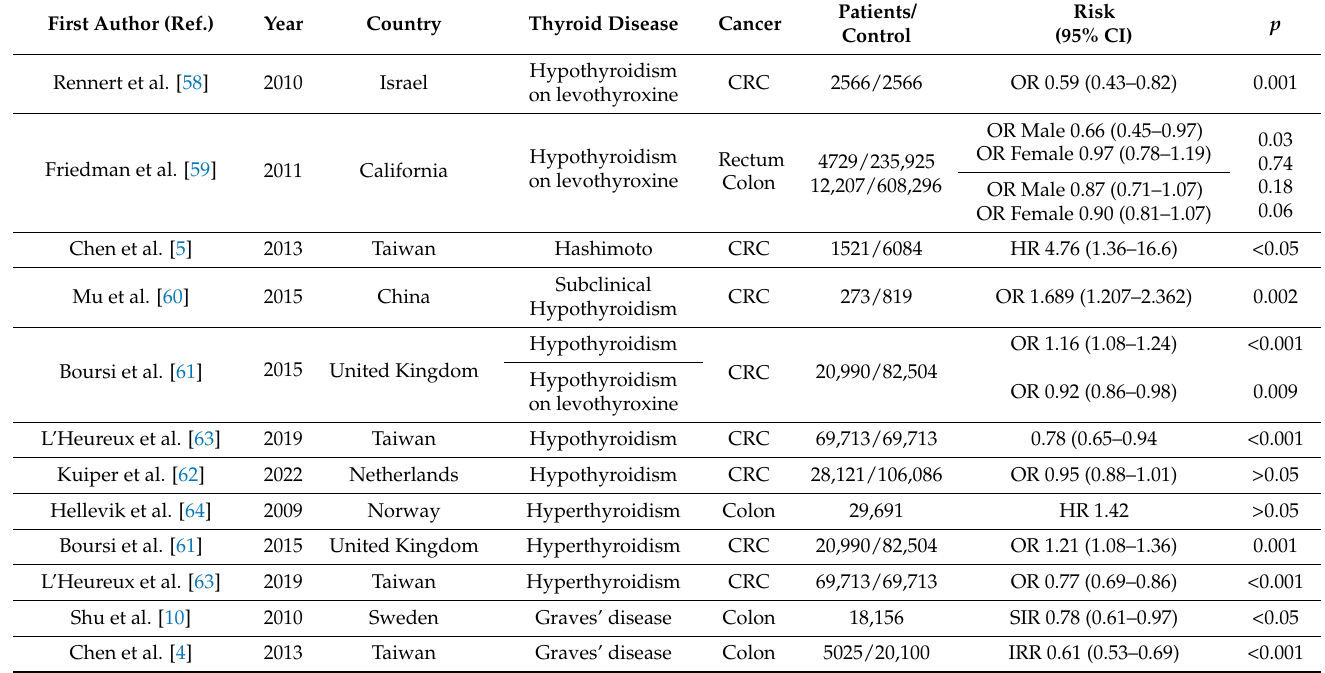
Table 1. Association of thyroid diseases with colorectal cancer . CI, confidence interval; CRC, colorectal cancer; OR, odds ratio; HR, hazard ratio; SIR, standardized incidence ratio; IRR, incidence rate